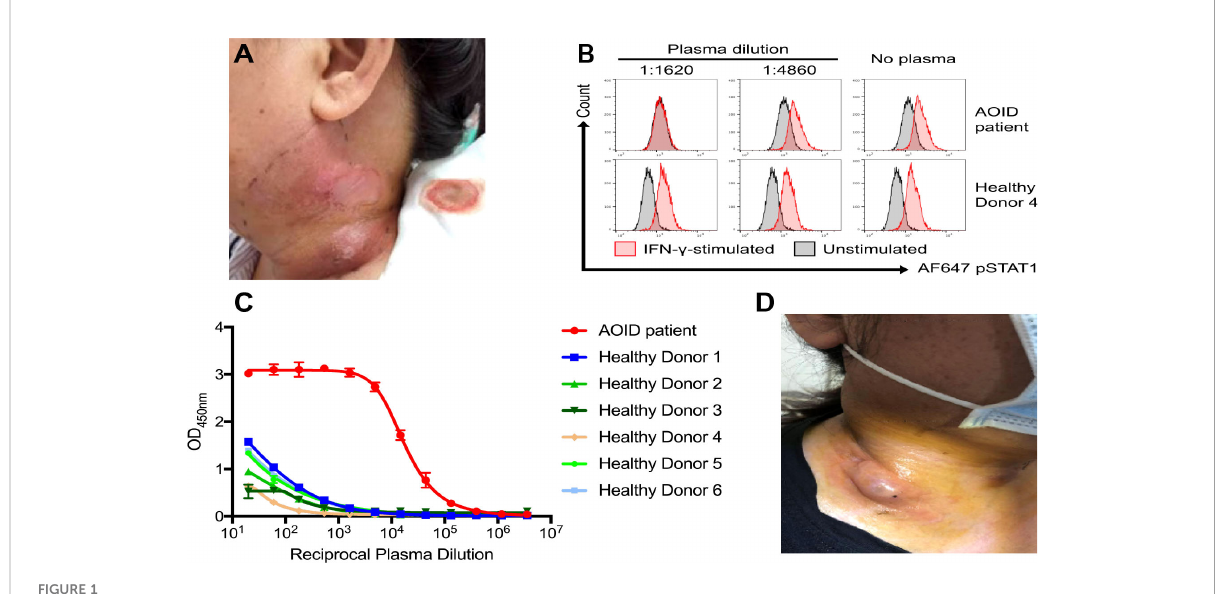
FIGURE 1 (A) The cervical abscess at admission. (B) STAT1 phosphorylation in THP-1 cells was inhibited when incubated with plasma sample from the patient at 1:1,620 dilution but remained consistent with samples from healthy donors. Representation of two independent experiments was shown. (C) Anti – IFN- g IgG were detected in the patient ’ s plasma using ELISA at depicted dilutions. STAT1, signal transducer and activator of transcription 1; IFN- g , interferon- g ; ELISA, enzyme-linked immunosorbent assay. (D) The deterioration of cervical abscess during